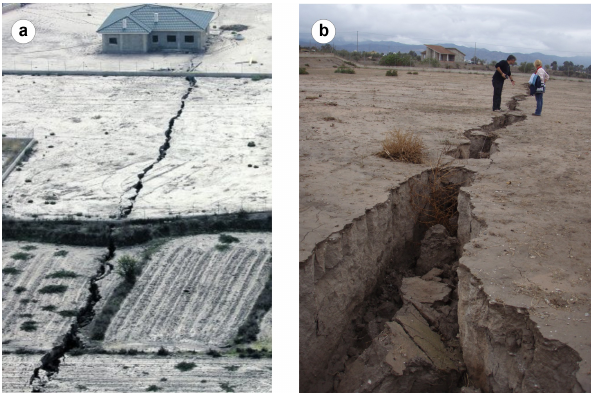
Figure 12. Compaction on clay soils interpreted due to compress- ibility after groundwater overexploitation. (a) Large crack develop- ment on vertisols in the Béjar fan distal area (source: La Verdad de Murcia). (b) Crack detail up to 150cm width and 2m